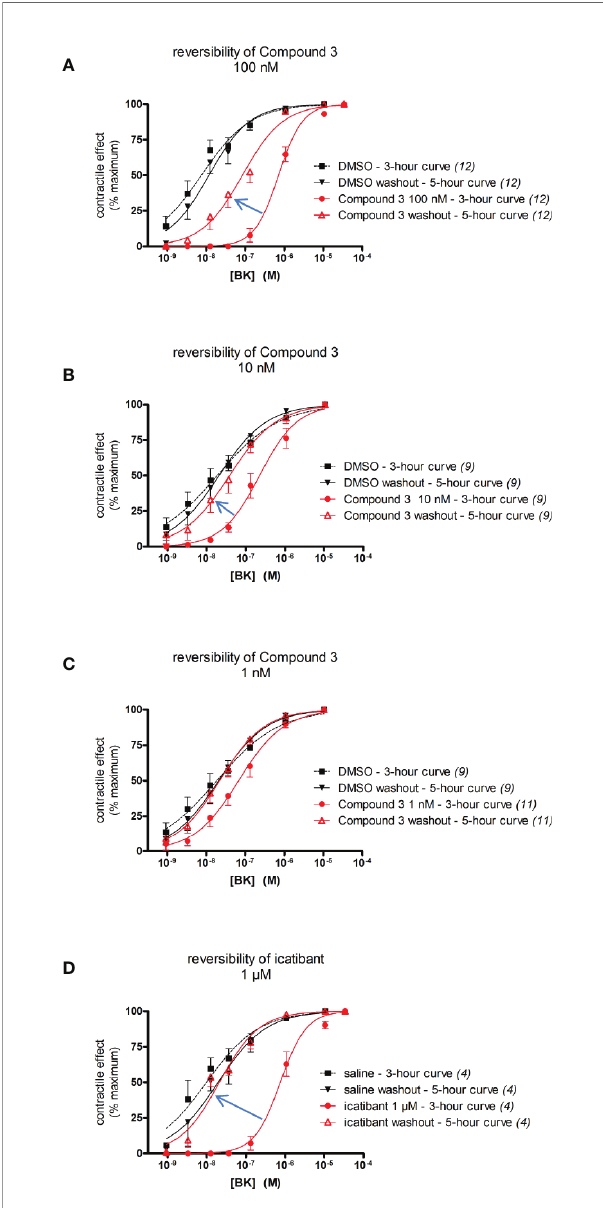
FIGURE 6 | Reversibility of the antagonist effect of selected B 2 receptor antagonists (concentrations as indicated, replicate number indicated between parentheses) in the human umbilical vein preparation following ample washing with fresh Kreb's solution. The apparent BK EC 50 values are reported in Tables 6 and 7 . (A – C) Reversibility of Compound 3 (100 nM, 10 nM, and 1 nM, respectively). (D) Reversibility of icatibant, 1 m M. The experiments reported in (B) and (C) have been conducted in parallel and share the same DMSO controls (presented twice in these panels). Values are the means ± S.E.M. of the number of determinations indicated by n . For the sake of clarity, several error bars below or above the average values have been